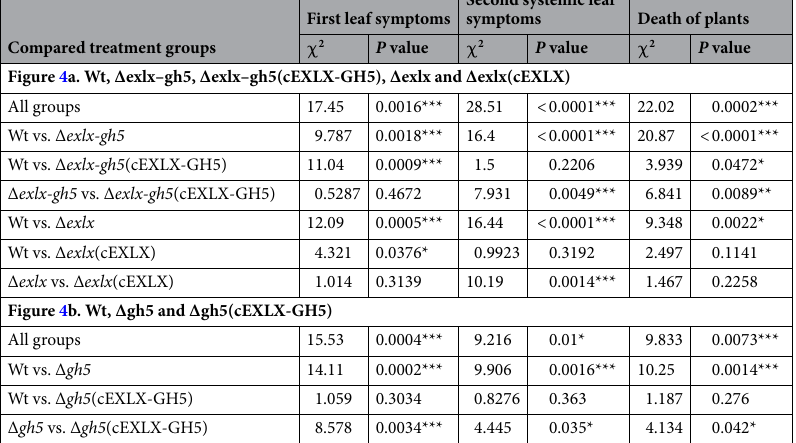
Figure 4b. Wt, Δgh5 and Δgh5(cEXLX-GH5) All